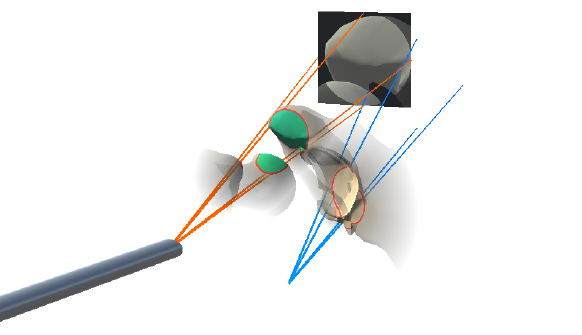
Figure 6. The orange frustum and depth-based colorization of the anatomical focus area show the current endoscopic pose, while the blue frustum and the in situ visualization without colorization shows the desired target